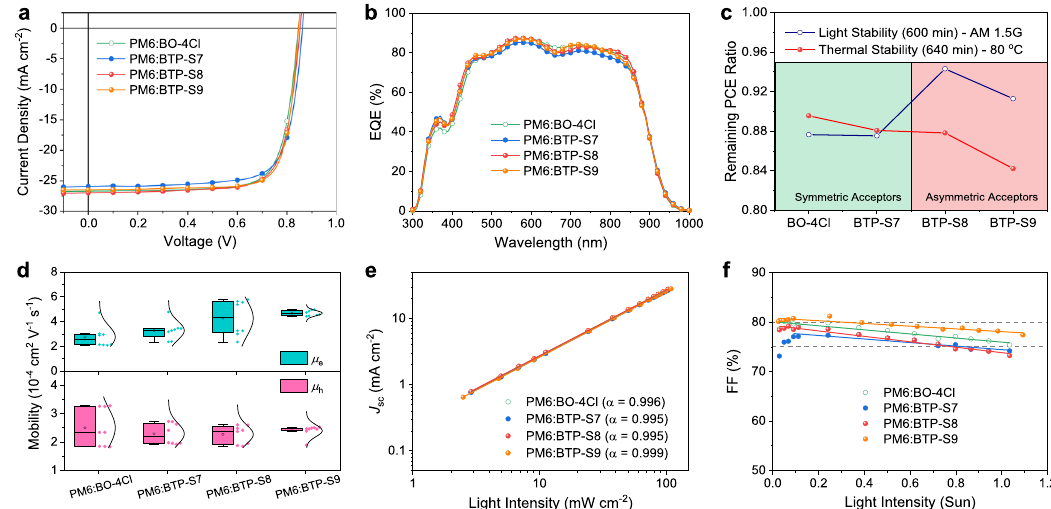
Fig. 2 Photovoltaic performance, charge transport, and recombination. a J – V curves of OPVs based on PM6:BO-4Cl, PM6:BTP-S7, PM6:BTP-S8, and PM6:BTP-S9 blends. b EQE curves of the relevant OPVs. c Light stability and thermal stability comparisons of relevant OPVs. d Hole mobility and electron mobility comparisons of relevant blends (error bar is de fi ned as the standard deviation, which is calculated from the statistics results of eight devices). e The dependence of J sc on light intensity ( P light ) of relevant OPVs. f The dependence of FF on P light of relevant